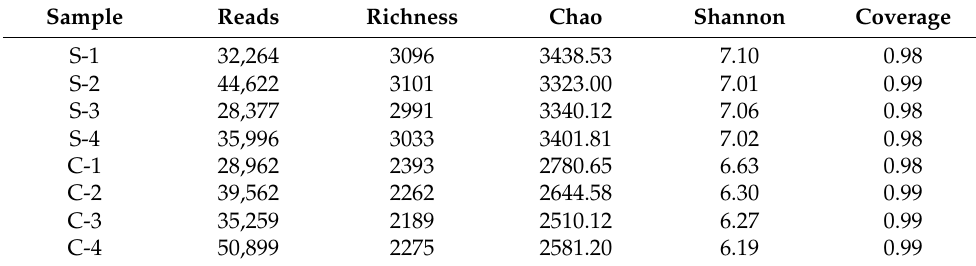
Table 3. Alpha-diversity estimators of the rhizosphere bacterial